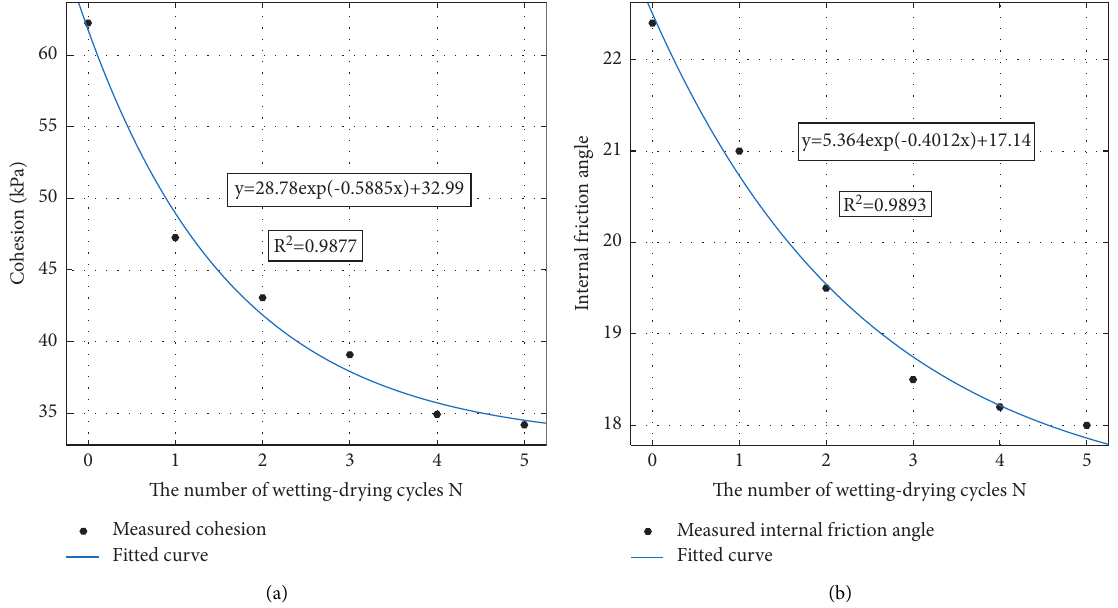
Figure 4: Relationship between shear strength parameters and wetting-drying cycles. (a) Cohesion. (b) Friction angle.